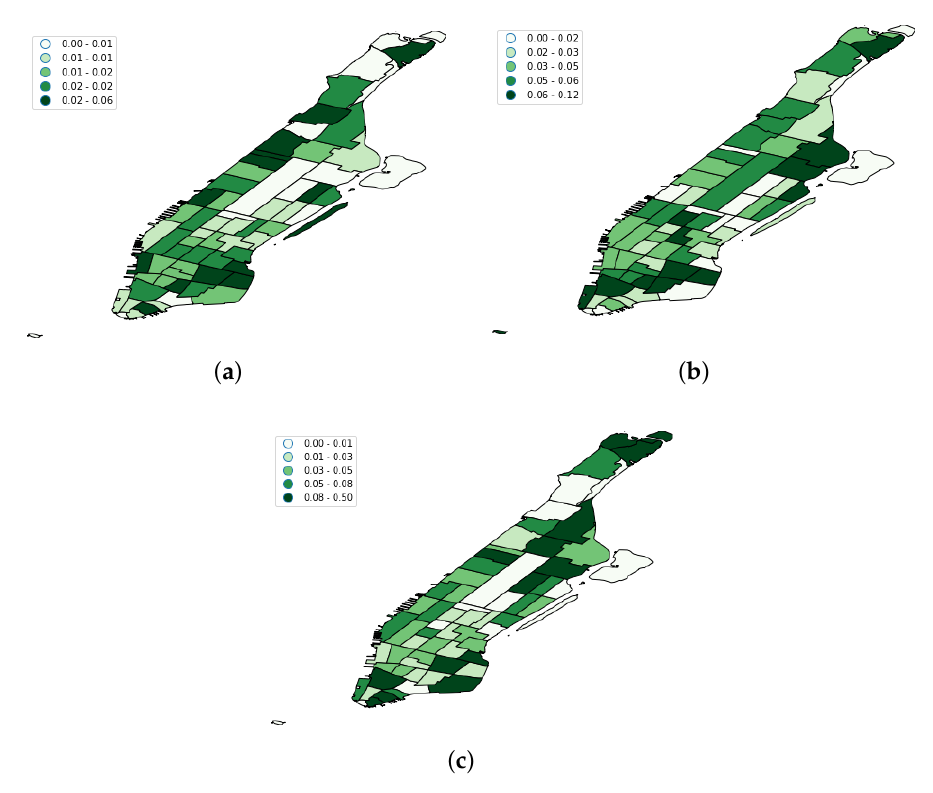
Figure 10. Spatial distribution of home user locations per taxi zone in the three OSNs. ( a ) Foursquare home user rates; ( b ) Flickr home user rates; ( c ) Brightkite home user rates.